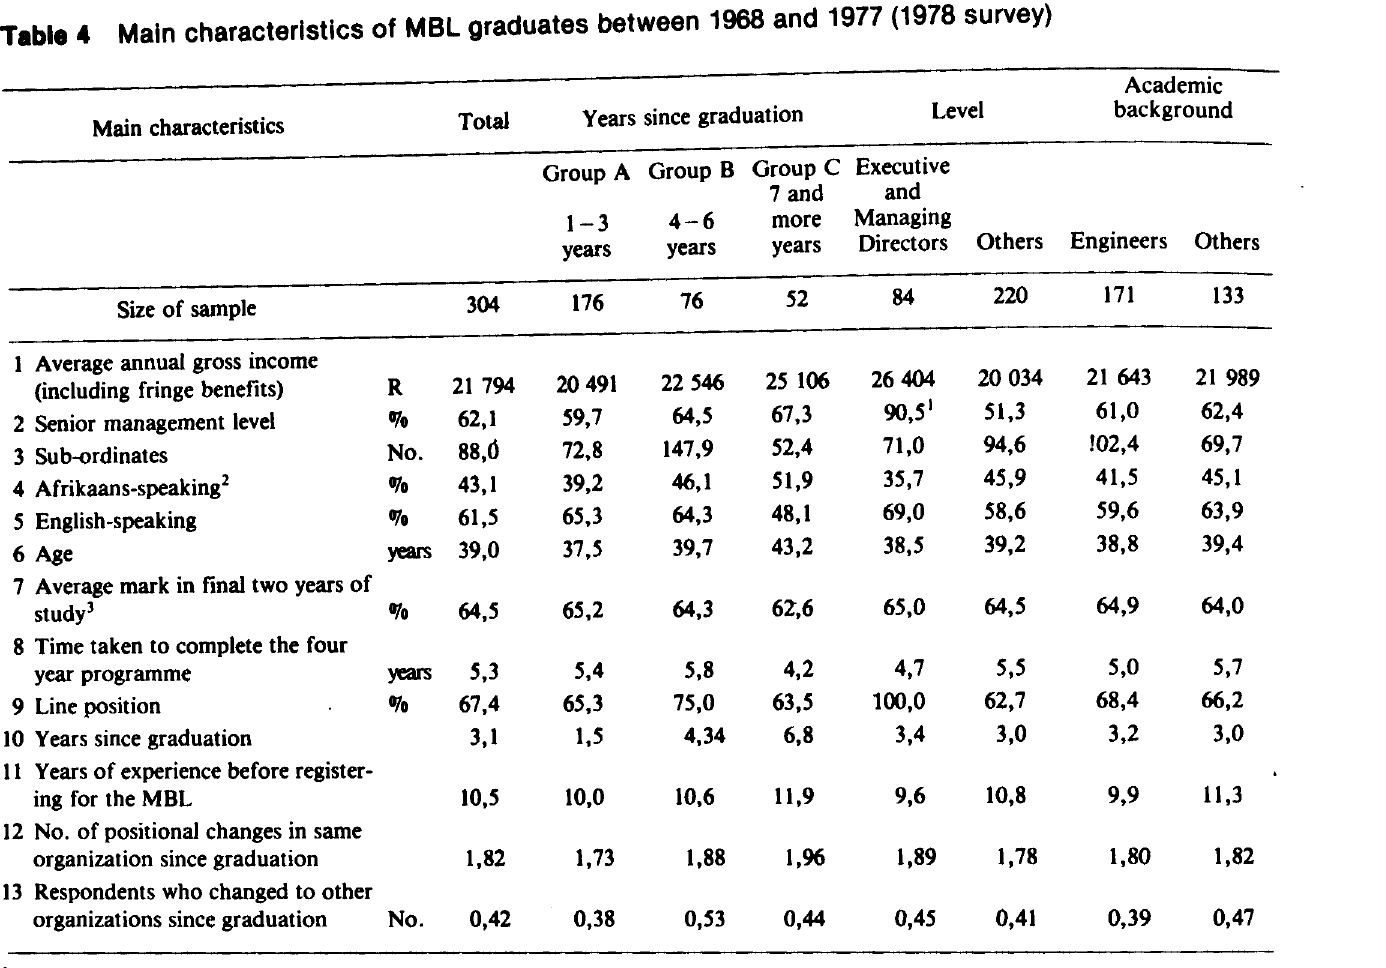
Main characteristics of MBL graduates between 1968 and 1977 (1978